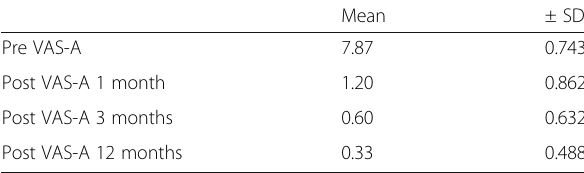
Table 1 Demographic data of the studied patients Table 3 Comparison between preoperative VAS-A and at different follow-up intervals among ACDF group Group P Significance